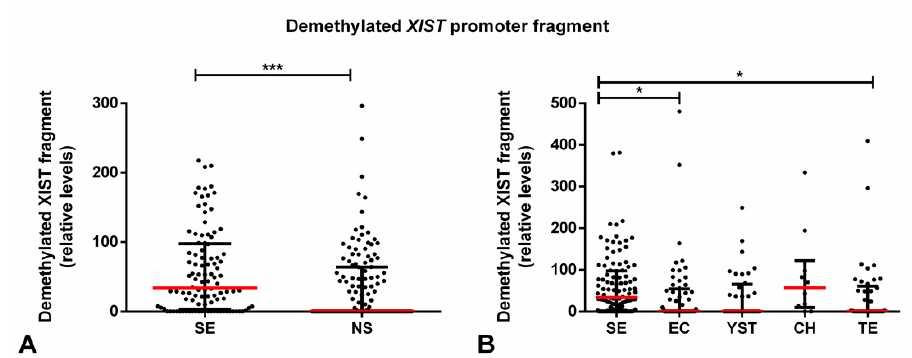
Figure 4. Demethylated XIST fragment relative amounts among various tumor subtypes of the discovery cohort. Relative amounts of the demethylated XIST fragment in ( A ) seminoma and non-seminoma and ( B ) all histological subtypes. *** indicates p < 0.001, * indicates p < 0.05. Abbreviations: